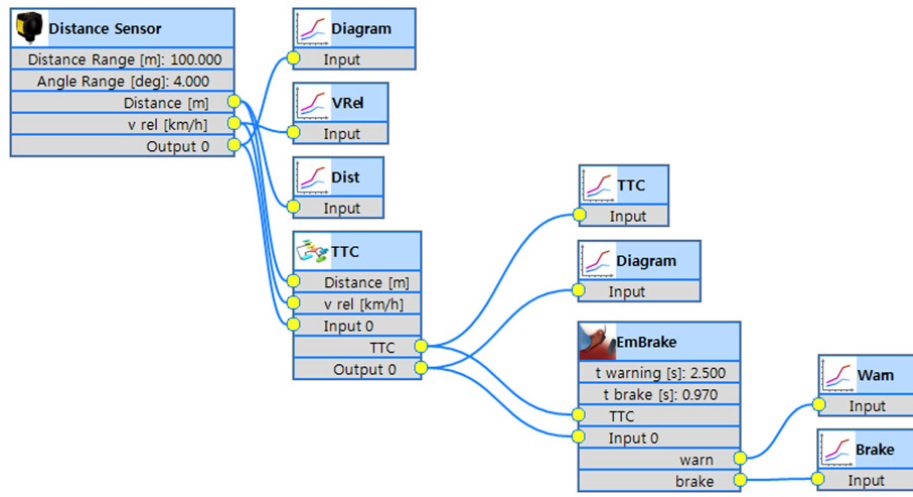
Figure 4. Active safety function of PC-Crash.